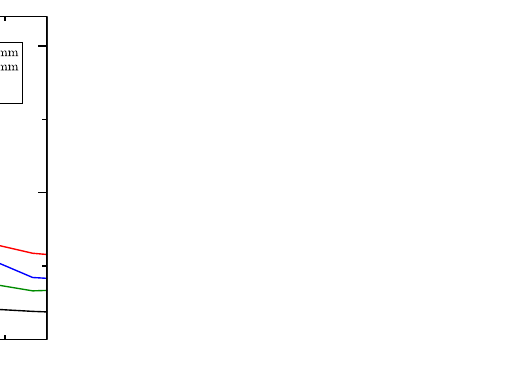
Figure 6. Energy scaled by peak energy function of the fluctuation wavelength for the three materials, measured by radial averaging of the power spectrum obtained by Fourier transform. Dotted lines indicate the peak